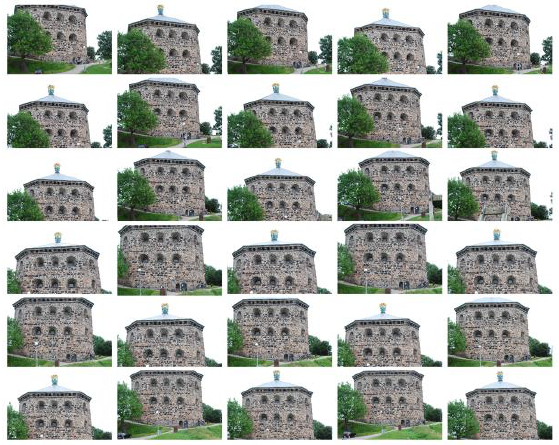
Figure 4 . Mult-view images of the